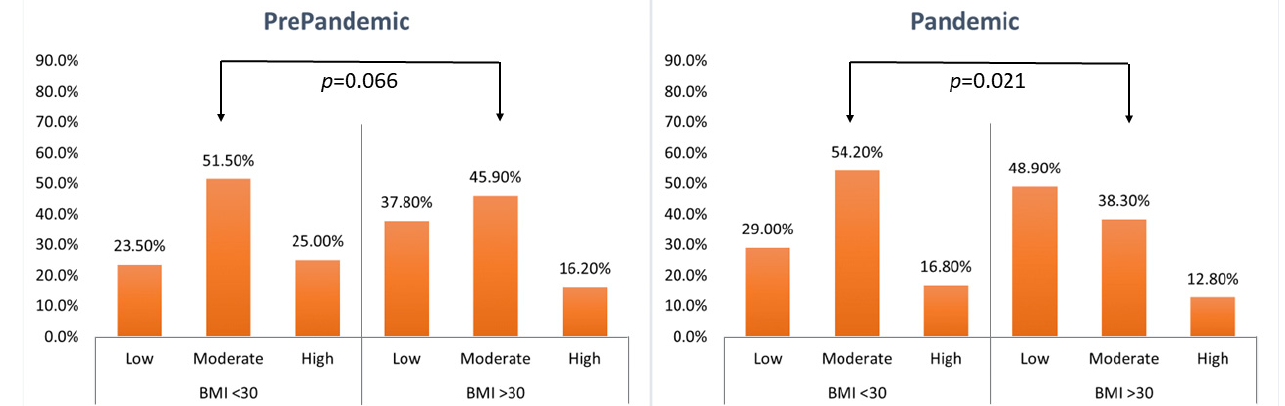
Figure 4. Assessment of physical activity at work or school (Mann–Whitney–Wilcoxon test).